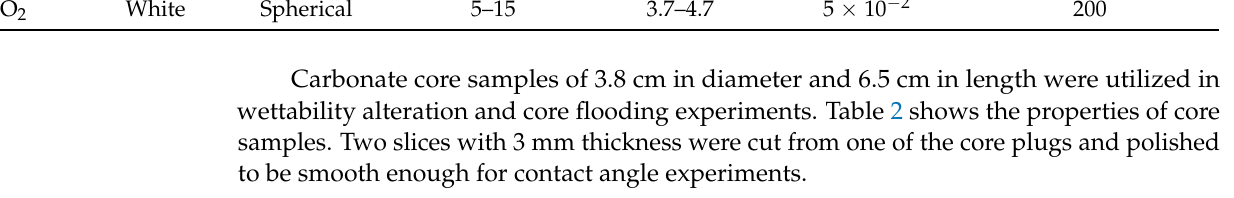
Table 2. The physical characteristics of the carbonate samples utilized in this survey. Core